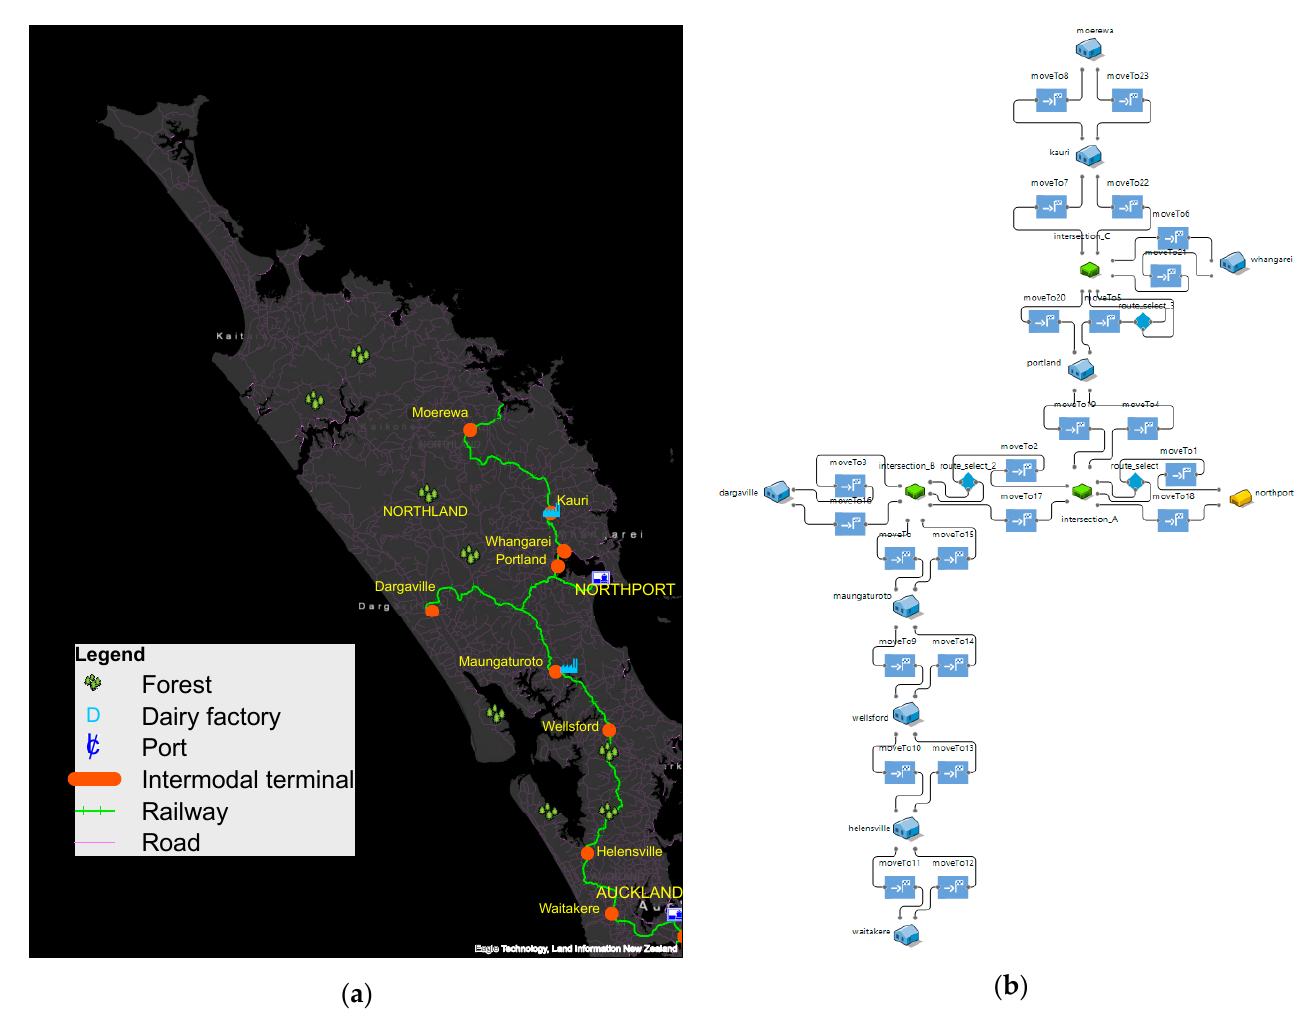
Figure 10. Simulation model main layout: ( a ) geographic representation; ( b ) logical